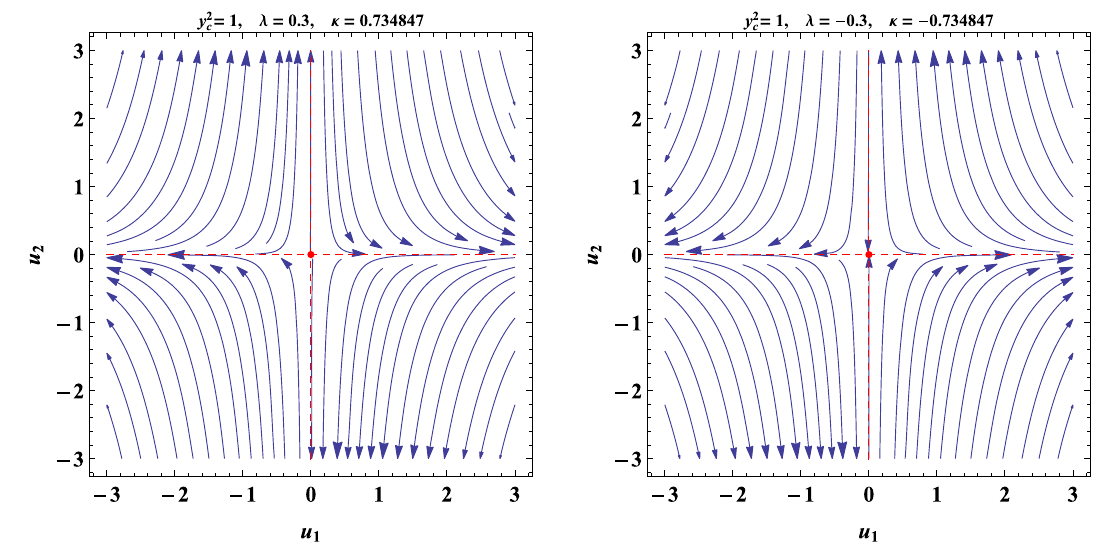
Fig. 7 Phase plot of system (70) for some values of the parameters showing that A (cid:4)